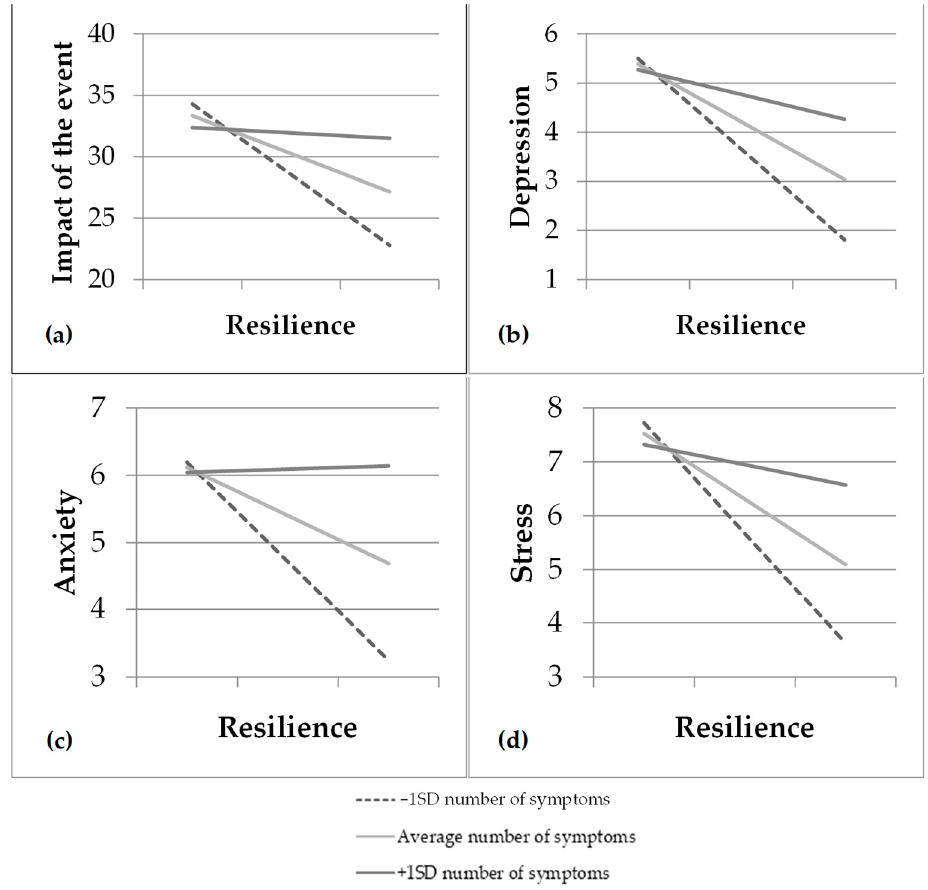
Figure 1. ( a ) Moderation of resilience on the traumatic impact of the event as a function of the number of symptoms of COVID-19; ( b ) moderation of resilience on depression as a function of the number of symptoms of COVID-19; ( c ) moderation of resilience on anxiety as a function of the number of symptoms of COVID-19; ( d ) moderation of resilience on stress as a function of the number of symptoms of COVID-19.